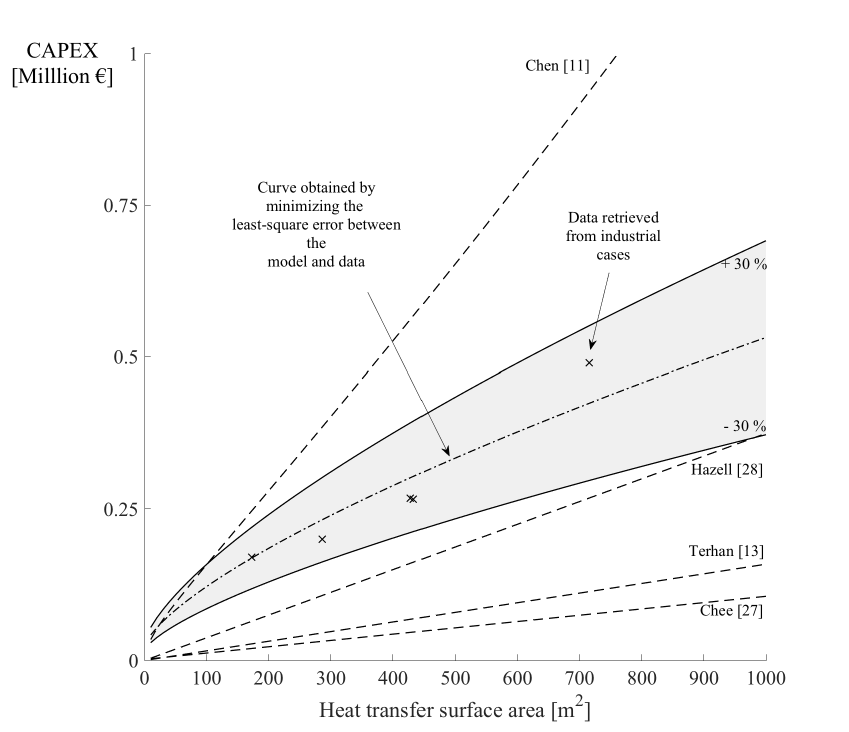
Figure 1. A comparison between the proposed model and the models suggested by Chen et al. [7], Hazell [22], Terhan and Comakli [12], and Che et al. [13]. The star dots represent the data